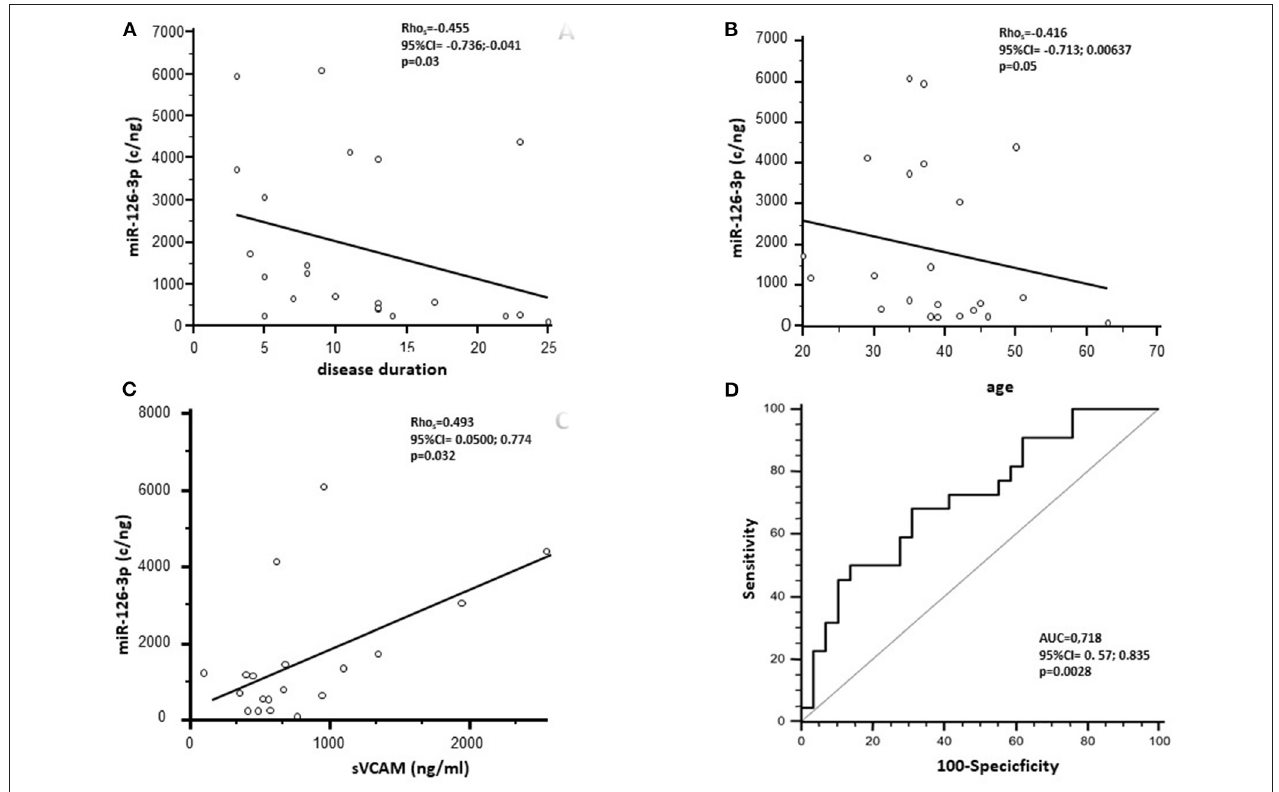
FIGURE 2 | Spearman’s correlation analysis between the miR-126-3p serum concentration (copies/ng) of RRMS subjects before NTZ treatment and disease duration (A) and age (B) . (C) Represents Spearman’s correlation between miR-126-3p serum concentration (copies/ng) and soluble (s)VCAM-1 in RRMS subjects. (D) Presents receiver operating characteristic curve (ROC) for the prediction of RRMS based on miR-126-3p serum concentration. AUC, area under the